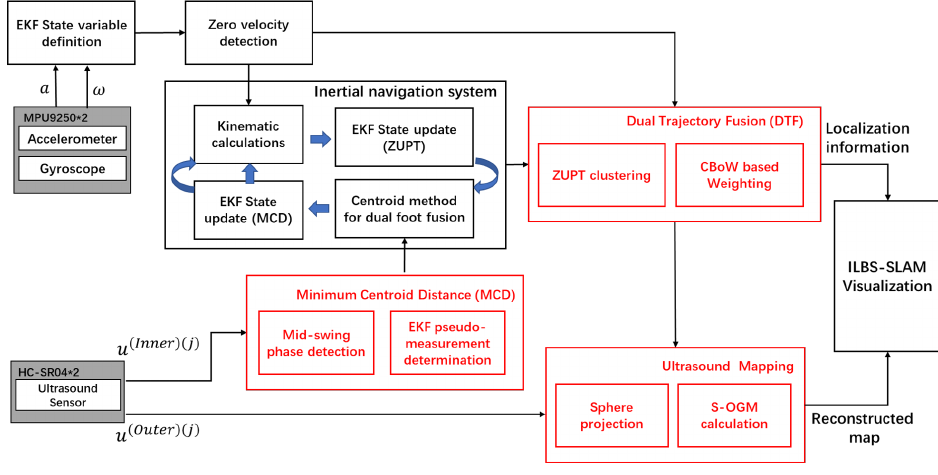
Figure 1. System overveiw of